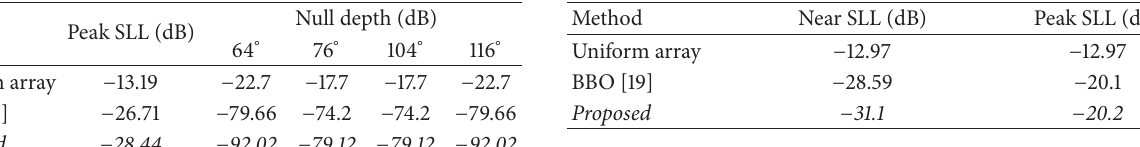
Table 15: Near SLL and peak SLL for Example 8 .